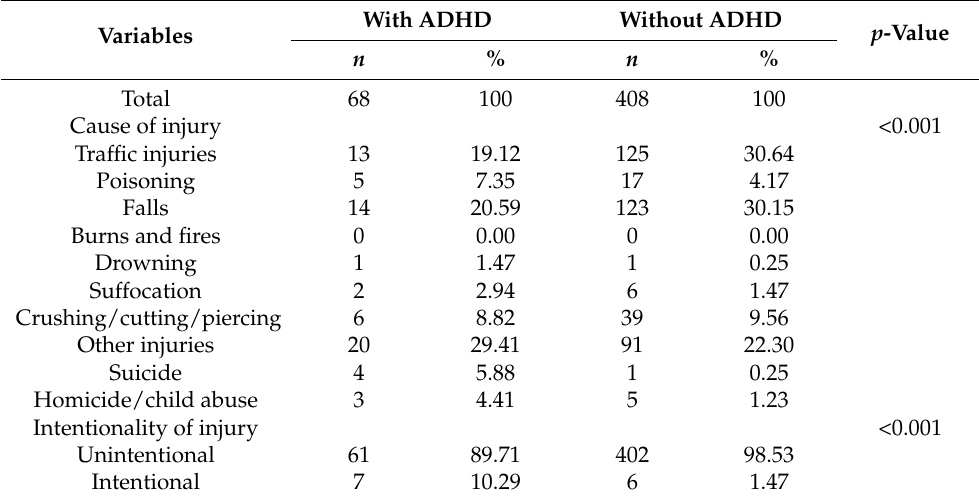
Table 8. Injured hospitalized children by cause of injury and group at the end of follow-up. With ADHD Without ADHD Variables